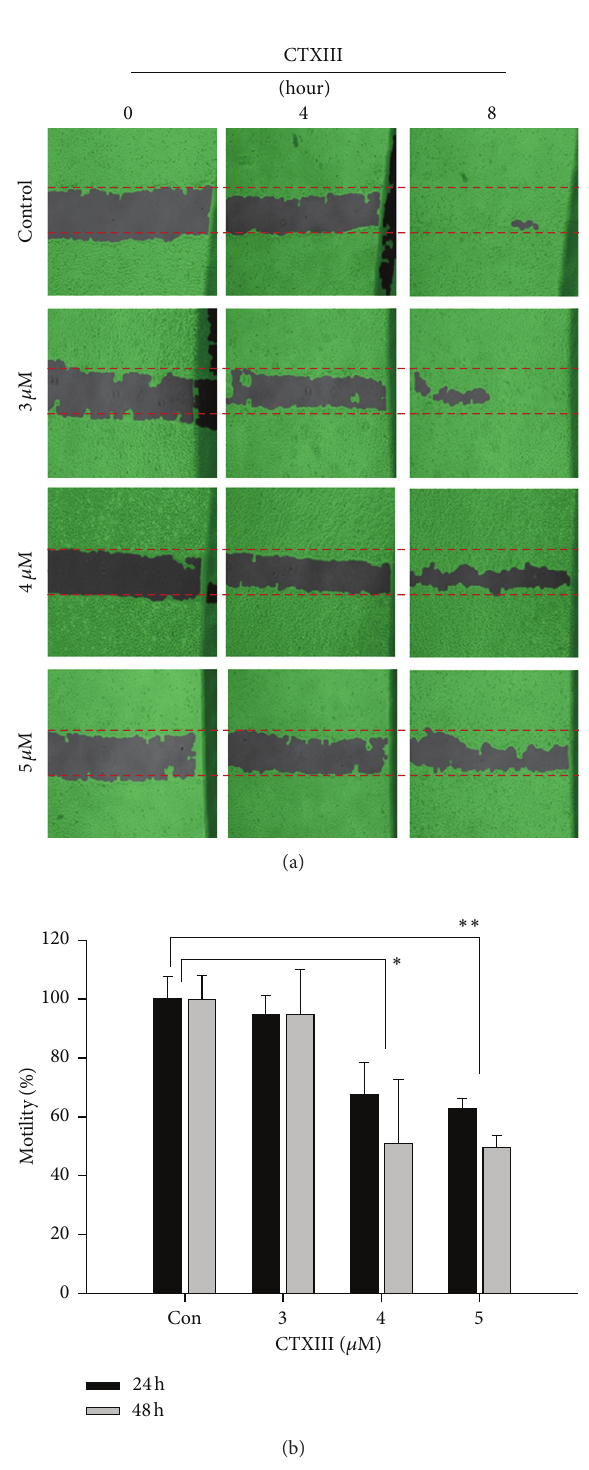
Figure 2: CTXIII inhibits cellular migration of Ca9-22 oral cancer cells. (a) 5 × 10 5 cells were seeded onto a 12-well plate, and cells were scraped to create a clean 1 mm wide wound area. Cells then were treated with the indicated doses of vehicle control, 3, 4, and 5 𝜇 g/mL of CTXIII for 8 hours. The wound areas were then analyzed and calculated using an online image analysis software Wimasis. (b) The quantitative results. Data, means ± SD ( 𝑛 = 3 ). ∗ 𝑃 < 0.05 and ∗∗ 𝑃 < 0.001 for control versus CTXIII treated, respectively.